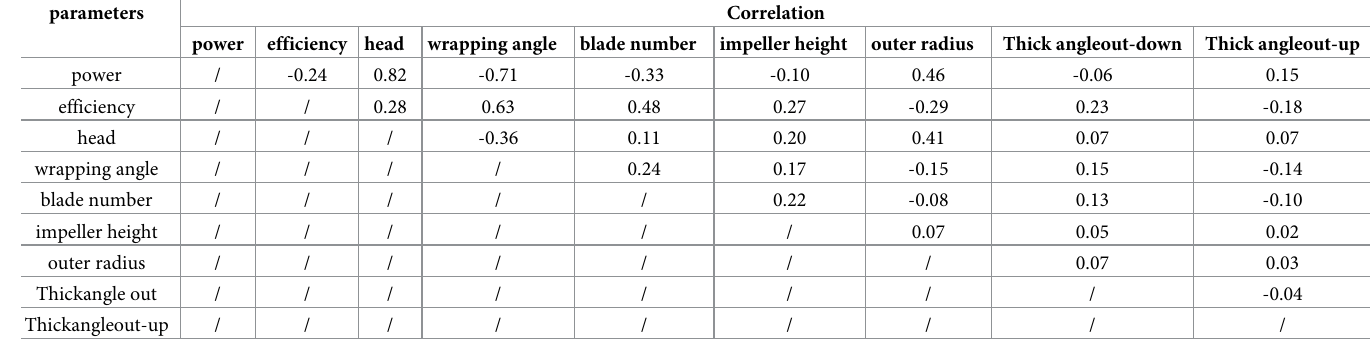
Table 5. Correlation analysis between two parameters.